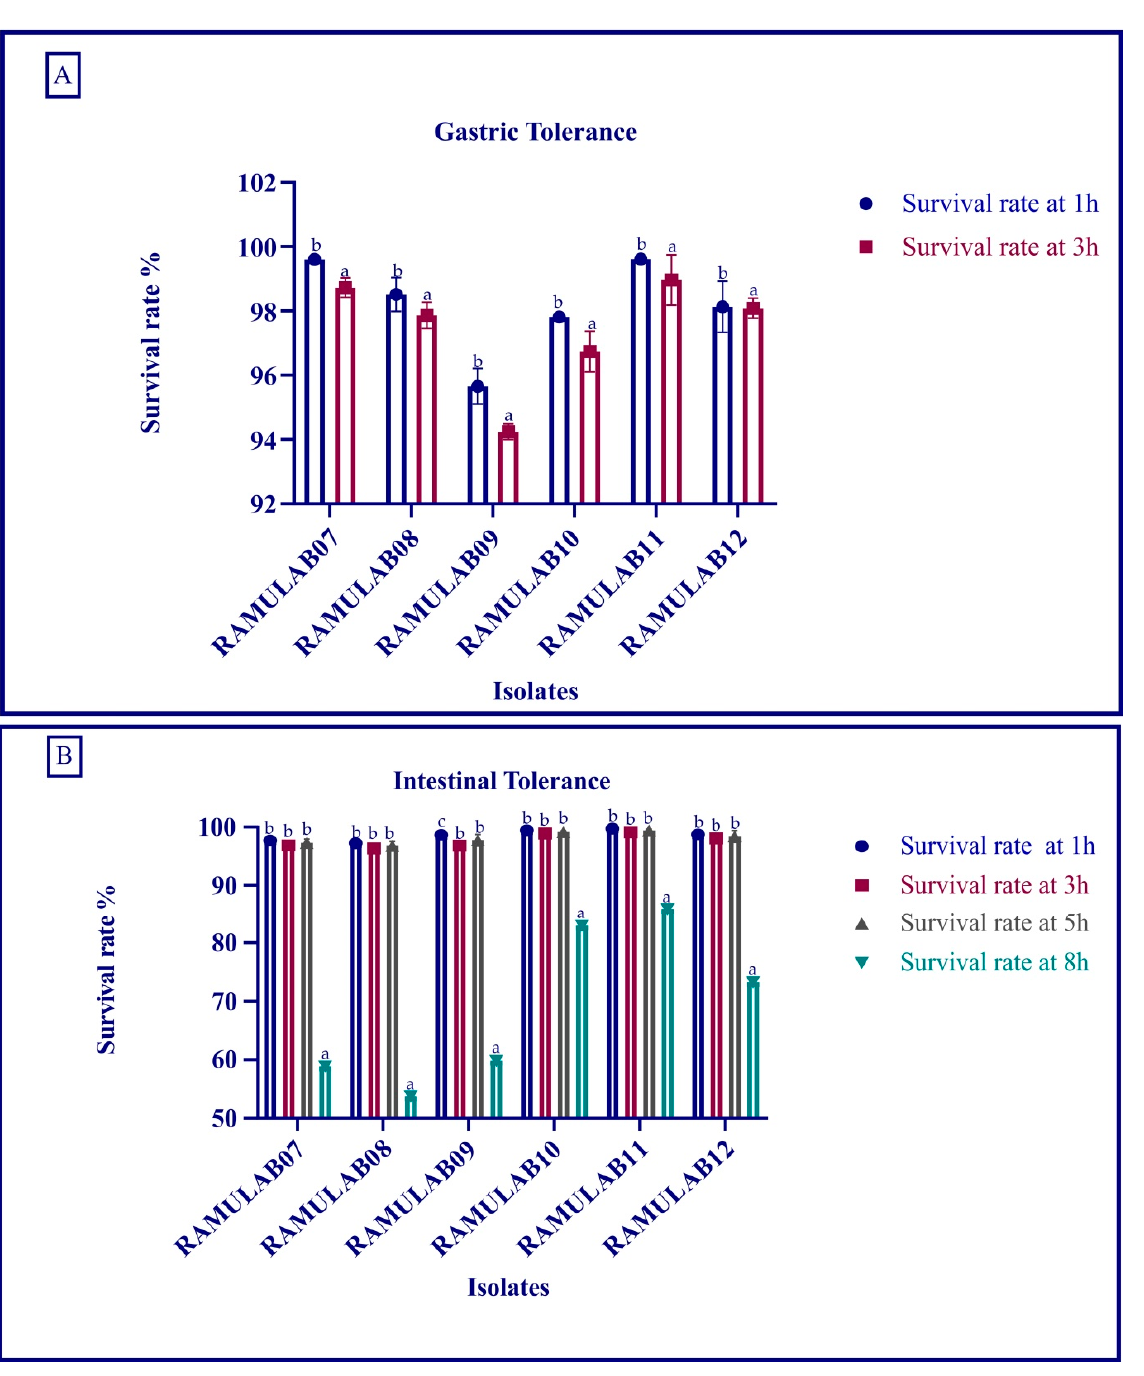
Figure 4. Survival rate of isolates in gastric ( A ) and intestinal ( B ) juice. Data are expressed as the mean ± SD. Means in survival rate for time interval (1 h, 3 h, 5 h, and 8 h) with distinct superscripts (a–c) are significantly different ( p ≤ 0.05), as separated by Duncan multiple range test.